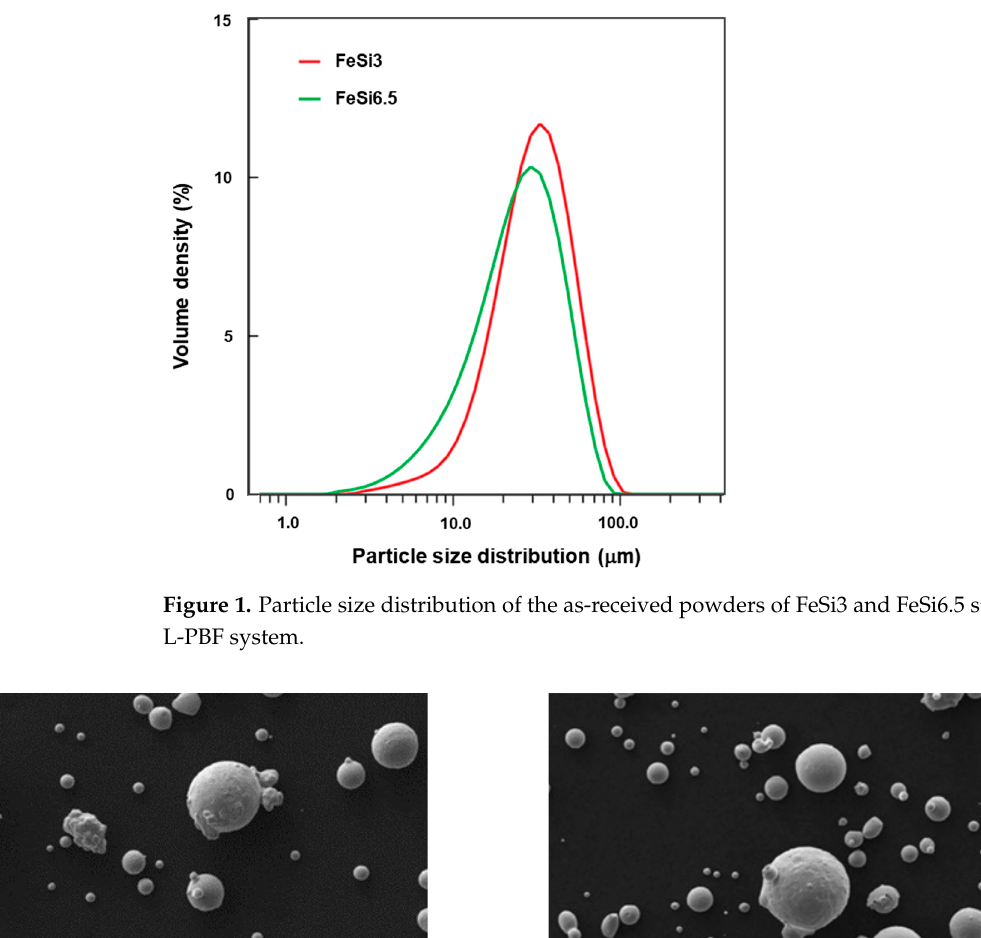
Figure 2. Powder steel morphology of FeSi3 ( a ) and FeSi6.5 ( b ), SEM images.